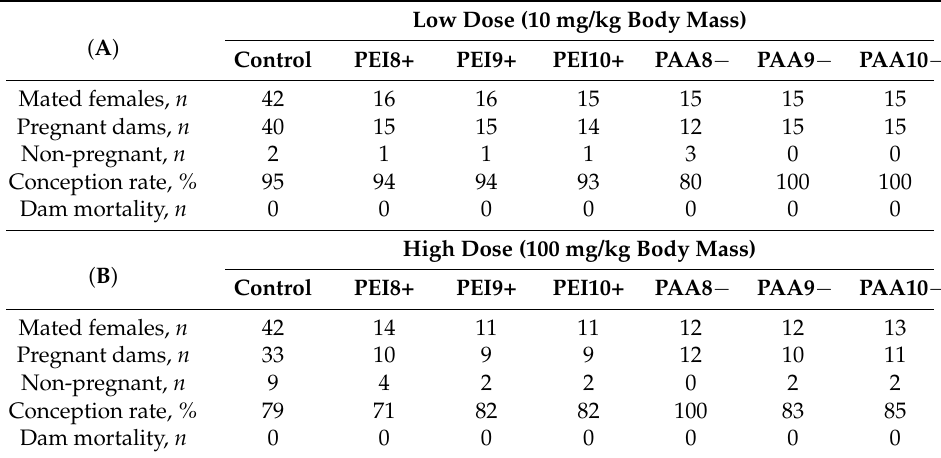
Table 1. Maternal parameters of mating and fertility for mice treated with 10 mg/kg ( A ) or 100 mg/kg ( B ) of iron oxide NPs during